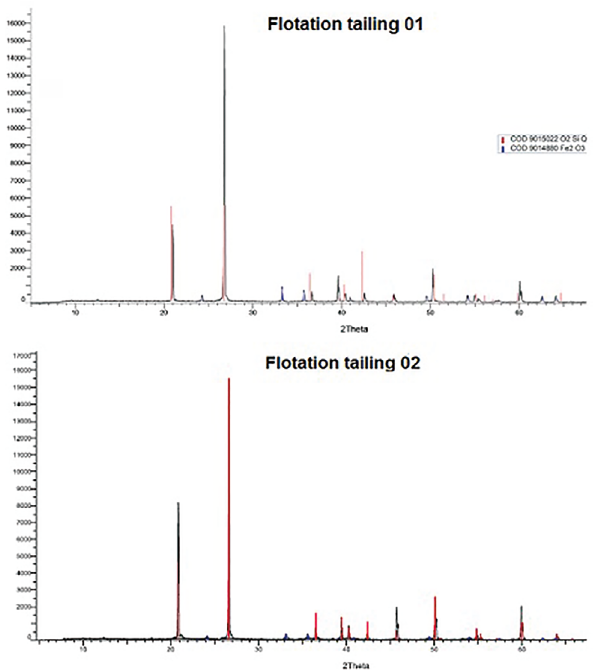
Figure 4. X-ray diffraction for flotation tailings 01 and